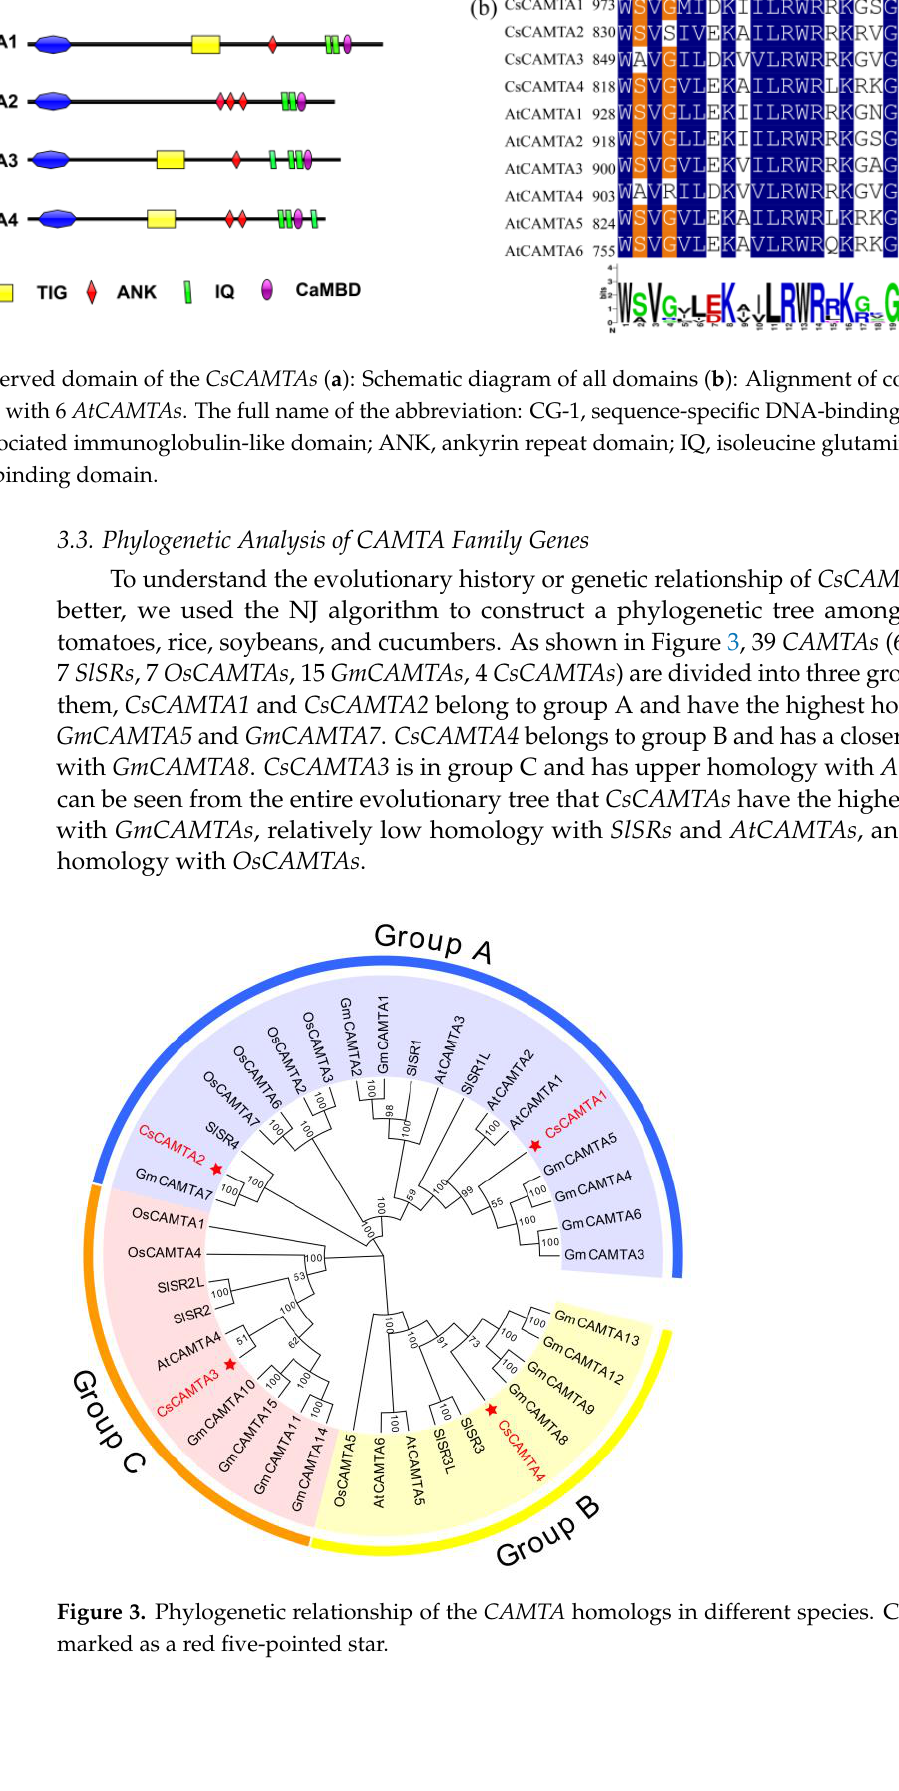
Figure 3. Phylogenetic relationship of the CAMTA homologs in different species. Cucumbers are marked as a red five-pointed star.